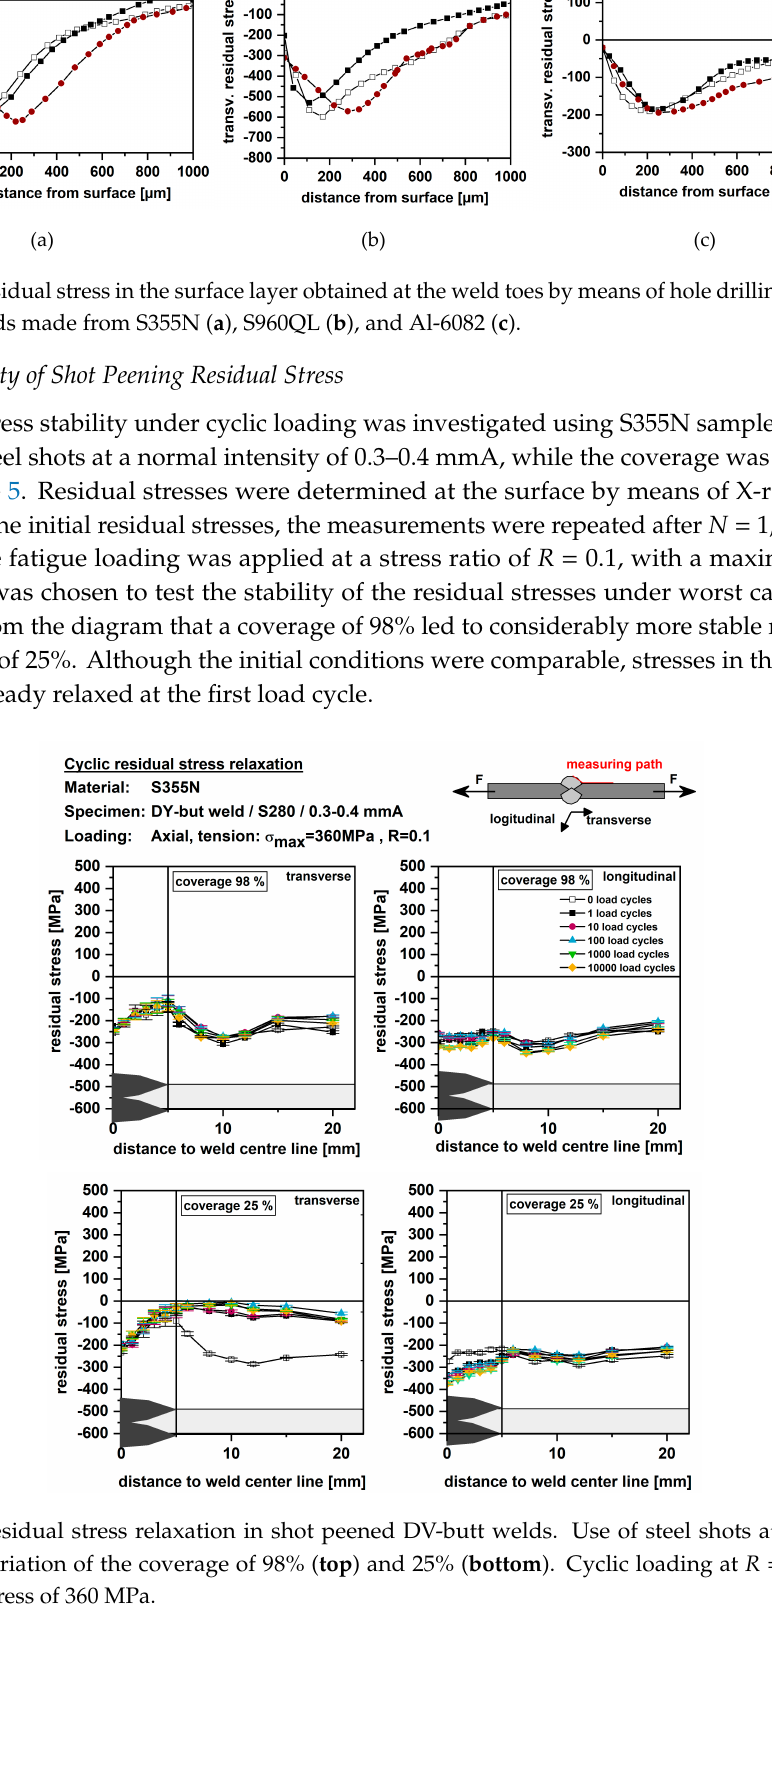
Figure 6. Change of residual stress depth profiles in shot peened (steel shots, intensity 0.3–0.4mmA, coverage of 98%) DV-butt welds under cyclic loading. Cyclic loading at R = 0.1 with maximum stress of 360 MPa. 3.3. Fatigue Test Results During fatigue testing, it was noted that the different shot peening parameters had only very little effect on the resulting fatigue strength enhancement of S355N DV-butt welds. Because of this, all results from test series 1–3, 10, 11, and 14–17 (all test series using S355N) were treated as the same population and analyzed together, as seen in Figure 7. All these test results are summarized here under the simplified term “clean blasted”, as no further distinction between the test series was made. The nominal fatigue strength range at 2 million load cycles was determined to ∆σ = 254 MPa (50% POS—probability of survival). Additionally, shown here are the test series peened by industry partners, according to a round robin principle (participants 1 to 3). These results show similar fatigue strength to the “clean blasted” condition. Overall, the test data covers the finite life region between 105 and 106 well. The regression line was determined to k ≈ 10. Run-outs (specimen without failure) were stopped at 5 million load cycles. The fatigue strength results from as-welded samples were determined in the IBESS-project and are given as a reference here [23]. Without going into details, the IBESS specimens were produced using the same welding parameters at the same facility. However, it must be pointed out that these tests were conducted at R = 0 and are not corrected to R = 0.1 due to its uncertain sensitivity to mean stress. The diagram further contains IIW FAT 90 (weld toe failure of untreated DV-butt welds) as a